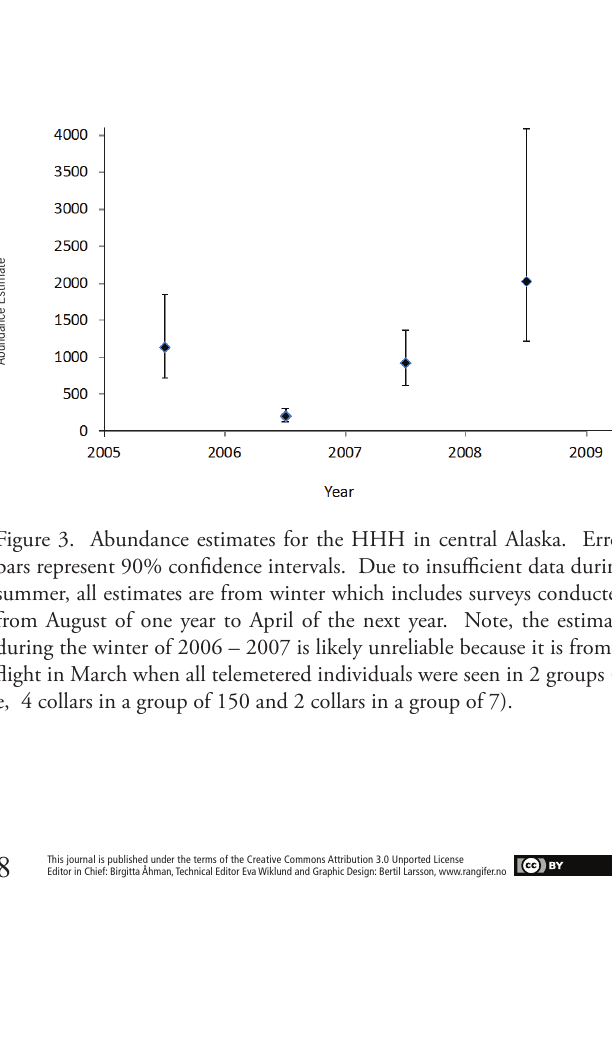
Figure 2. Abundance estimates for the RMH in central Alaska. Error bars represent 90% confidence intervals. Winter estimates are from surveys conducted from August of 1 year to April of the next year and summer estimates are from surveys conducted from May to July of the same year.